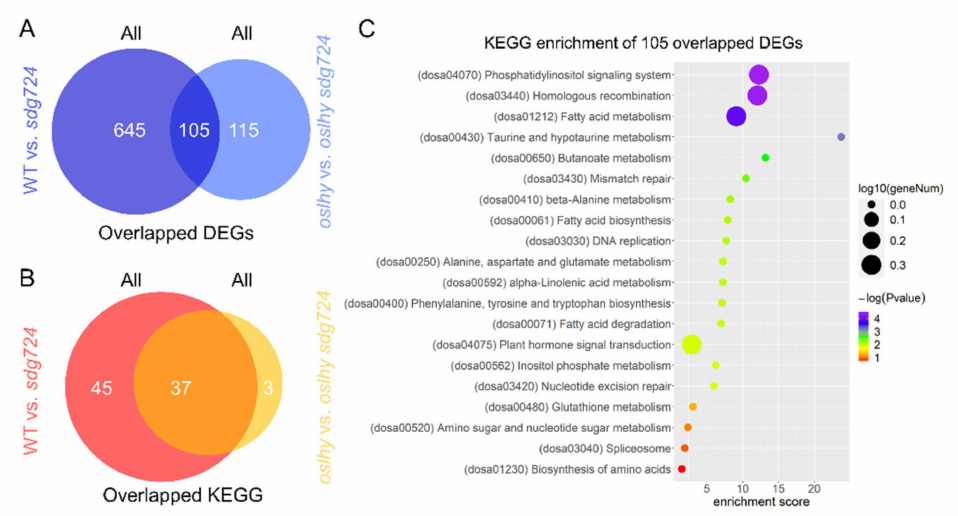
Figure 2. The influence of OsLHY on SDG724 . ( A ) Overlapped DEGs between the WT vs. sdg724 and oslhy vs. oslhy sdg724 comparisons. ( B ) Overlapped KEGG pathways between the WT vs. sdg724 and oslhy vs. oslhy sdg724 comparisons. ( C ) KEGG enrichment of 105 overlapped DEGs between the WT vs. sdg724 and oslhy vs. oslhy sdg724 comparisons. All indicates all of the DEGs. KEGG enrichment analysis revealed that the DEGs of the WT vs. sdg724 comparison were enriched in 82 pathways, and the DEGs of oslhy vs. oslhy sdg724 comparison